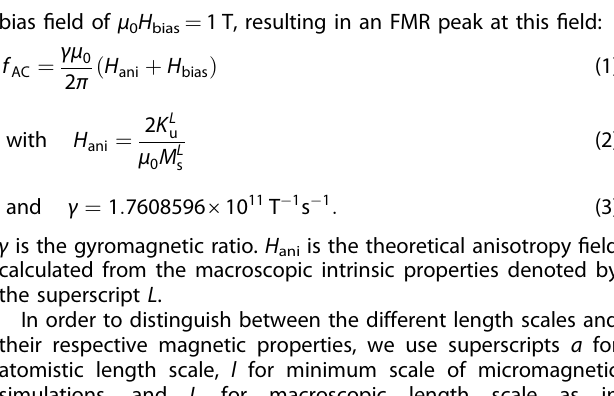
Fig. 1 FMR spectra calculation setup. Scheme of setup to calculate the FMR spectra for a permanent magnetic cube with various mesh sizes. The bias fi eld is applied in direction of the z -axis, i.e., parallel to the magnetocrystalline anisotropy axis, and the oscillating fi eld acts in x -direction. The x -component of the magnetization is used to calculate the response of the system for each bias fi eld.